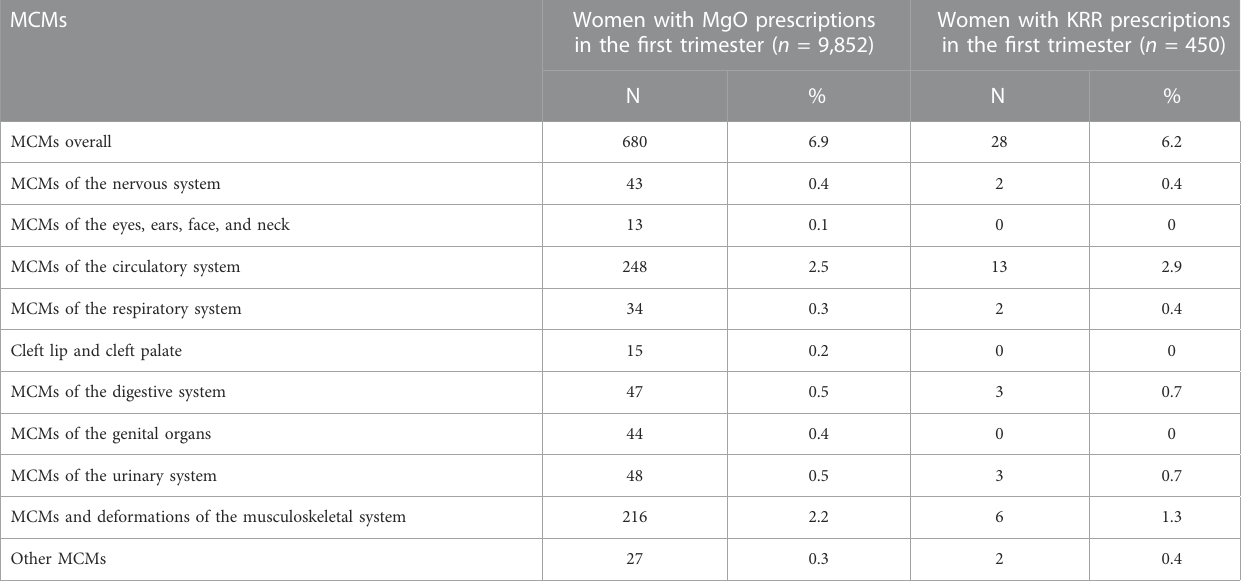
TABLE 3 Prevalence of MCMs in the two groups. MCMs